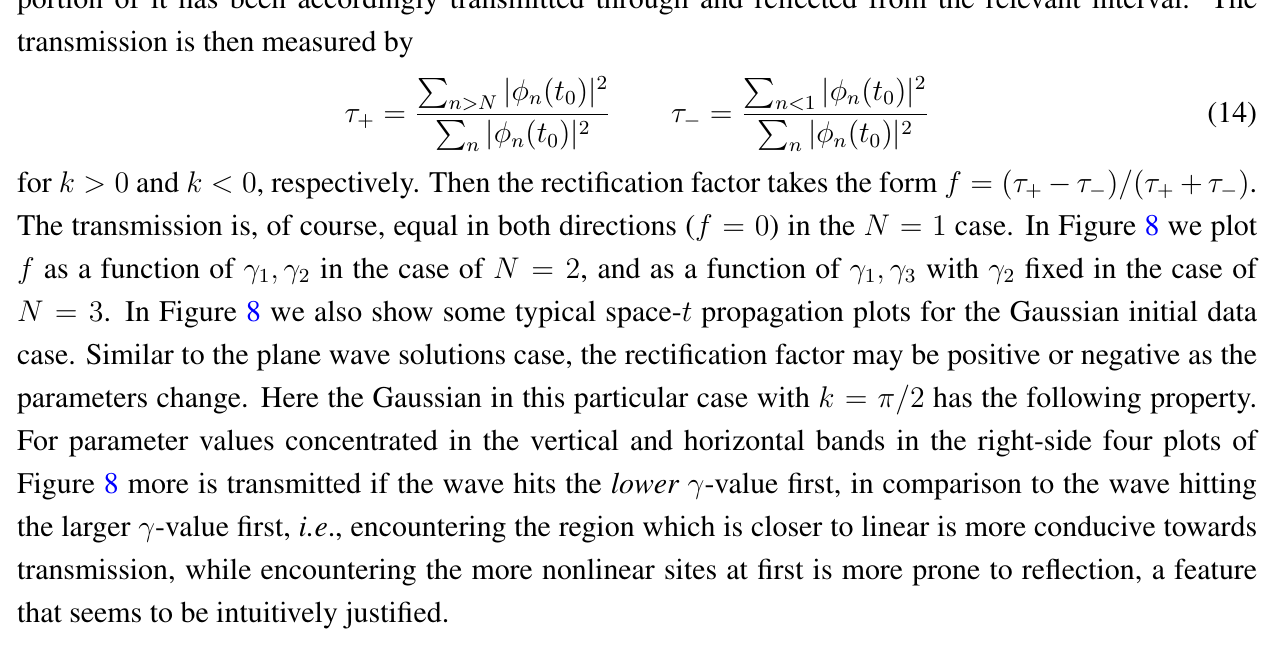
( t ) | 2 as a function of the lattice n and the Figure 8. In the left four graphs, we plot | φ n propagation variable t for initial profile according to Equation (13) with | I | 2 = 2 . 5 . The left = − 50 and the right columns columns have wavenumber k = π/ 2 and starting position n 0 = 50 . The top two plots correspond have wavenumber k = − π/ 2 and starting position n 0 = 2 . 75 and γ = 5 ; we calculate that the rectification factor in this case is to N = 2 with γ 1 2 f ≈ − 0 . 1767 . The bottom two plots correspond to N = 3 with γ = 3 , γ = 3 . 25 , γ = 4 ; 1 2 3 we calculate that f ≈ − 0 . 1525 . In the right four graphs, we plot the rectification factor of the Gaussian waves for N = 2 (left column) and N = 3 (right column) as a function of variable γ parameters. The top row corresponds to | I | 2 = 1 in Equation (13) and the bottom row to | I | 2 = 2 . 5 . For the N = 3 plots, the value γ = 5 (top) and γ = 3 . 25 (bottom) is fixed. 2 2